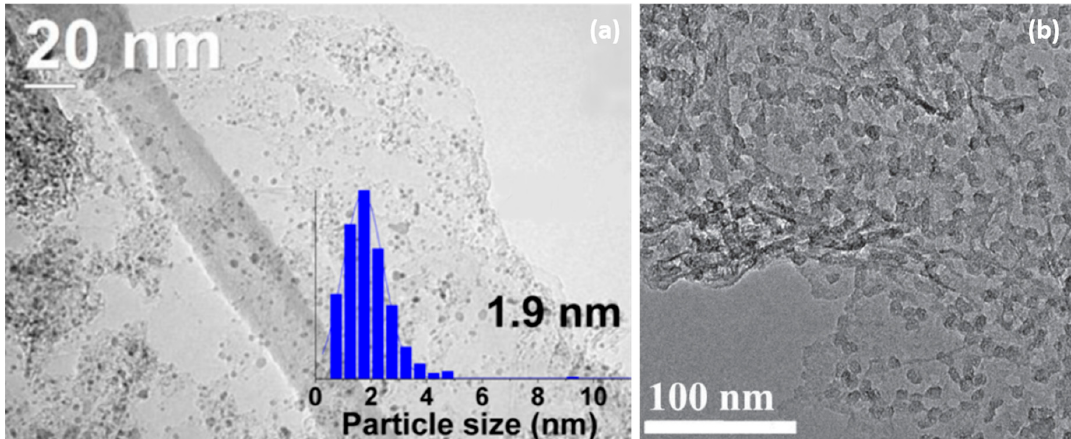
Figure 12. TEM images of nanoconfined NPs. ( a ) Rh NPs supported on HSAG prepared by impregnation with a RhCl 3 aqueous solution and subsequent reduction in Ar/H 2 at 200 °C. The inset shows the particle size histogram. Reprinted with permissions from [110] (copyright 2015 American Chemical Society). ( b ) MgH 2 NPs self-assembled on graphene, obtained by hydrogenation of adsorbed MgBu 2 . Reprinted with permissions from [67] (copyright 2015 Wiley-VCH).